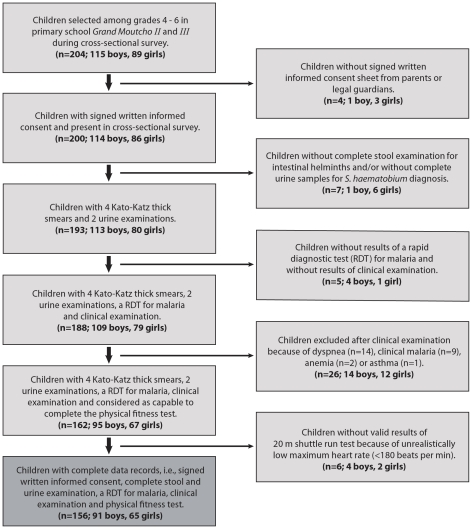
Study participation and compliance.Diagram showing the study participation and compliance of school children attending grades 4-6 of the primary school Grand Moutcho II and III, near Agboville, a rural community of south Côte d'Ivoire in early 2010.